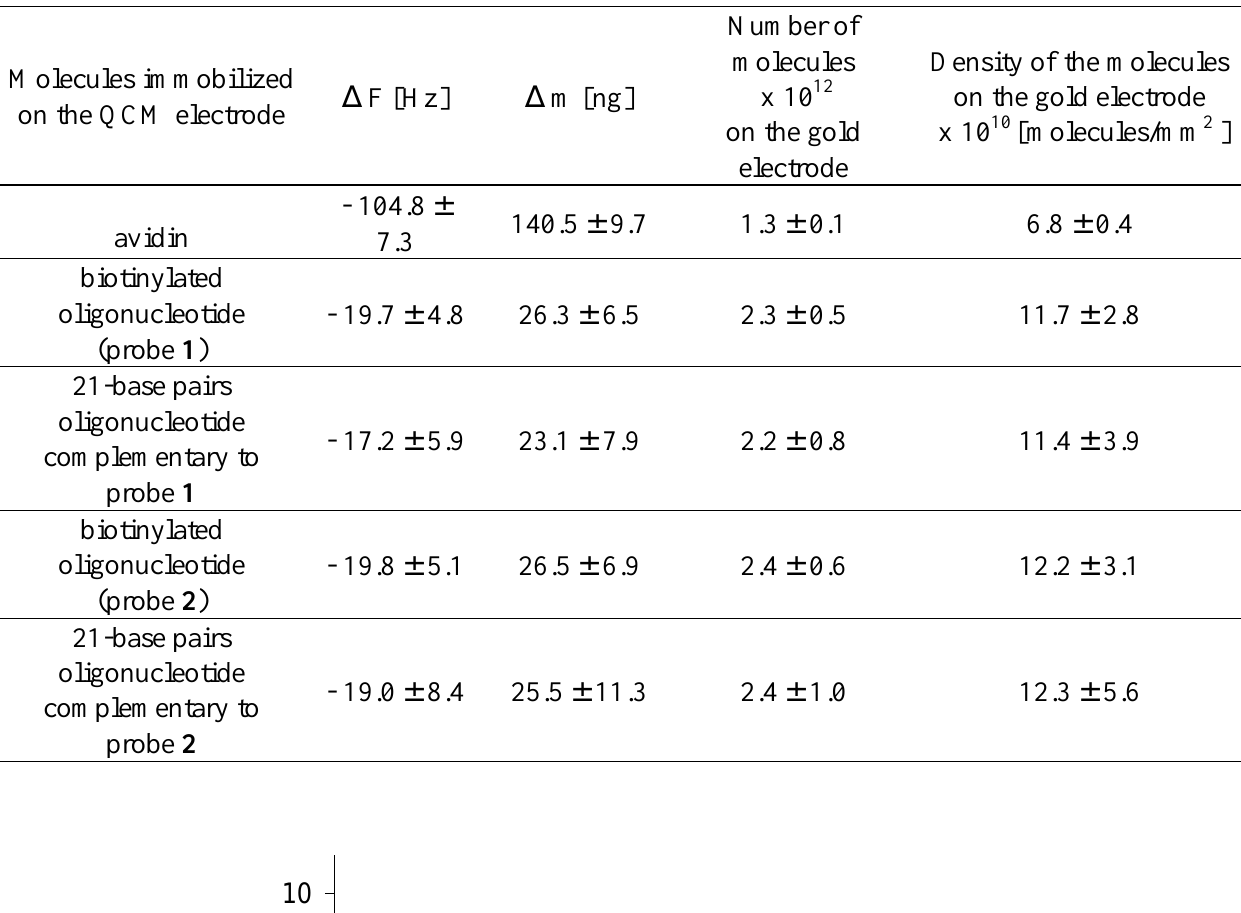
Table 1. Changes of: frequency, mass, number and density of molecules for the consecutive steps of modification of QCM electrodes (n = 5 - 10).